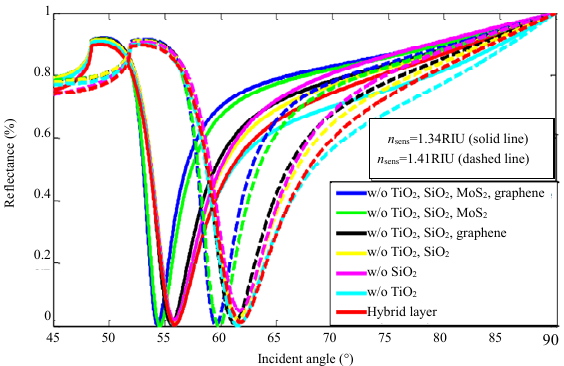
Fig. 5 Variation of the Reflection Intensity with respect to the incidence angle for different structures of SPR sensor.